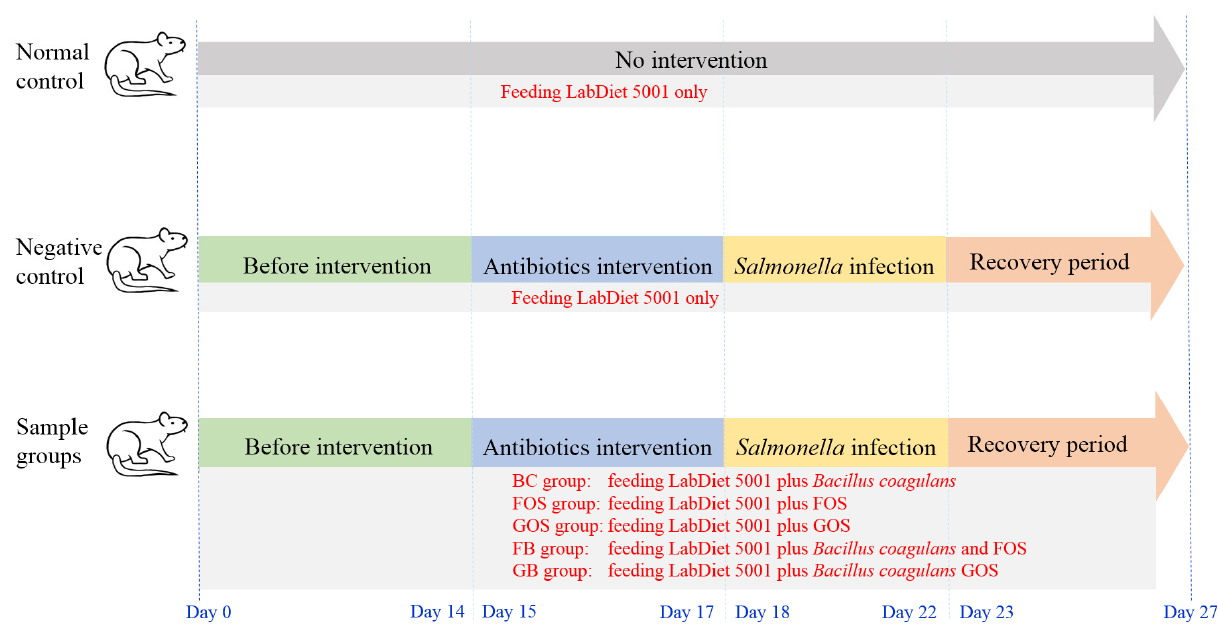
Figure 1. Schematic diagram of the experimental design in vivo .